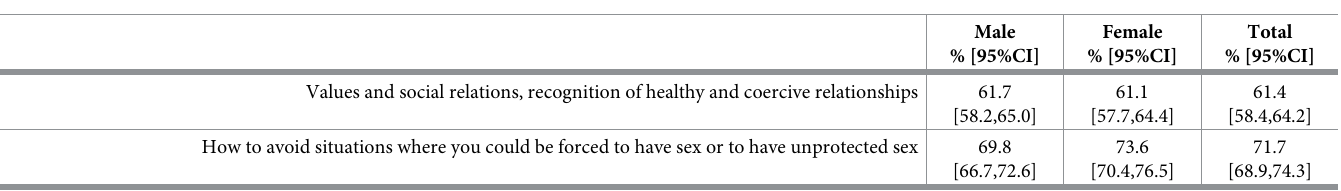
Table 5. Distribution of outcomes related to CSE components by gender, Me´xico 2014.